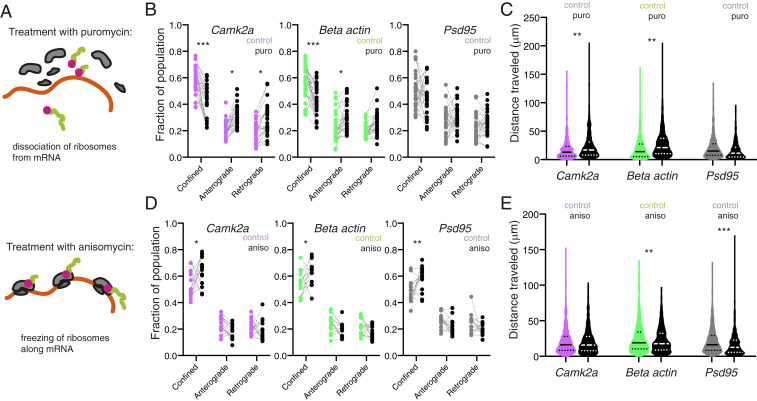
Manipulating ribosome association of mRNAs results in transcript-specific alterations in mRNA dynamics. (A) Schematic representation of the effects of puromycin (Upper) or anisomycin (Lower) on ribosomal association with mRNA. Puromycin results in ribosomal subunit disassembly, whereas anisomycin results in stalling of elongating ribosomes. (B) Quantification of mRNA dynamic state: confined, anterograde vs. retrograde for Atto647N Camk2a, Atto647N β-actin, and Atto647N Psd95 for control vs. puro treated samples. n = 29 cells per condition. *P < 0.05; ***P < 0.001. Paired t test. (C) Quantification of cumulative distance traveled for Atto647N Camk2a, Atto647N β-actin, and Atto647N Psd95 for control vs. puro-treated samples. n = 29 cells per condition. **P < 0.01 Sidak’s multiple comparisons test. (D) Quantification of mRNA dynamic state: confined, anterograde vs. retrograde for Atto647N Camk2a, Atto647N β-actin, and Atto647N Psd95 for control vs. anisomycin-treated samples. n = 15 cells per condition. *P < 0.05; **P < 0.01 paired t test. (E) Quantification of cumulative distance traveled for Atto647N Camk2a, Atto647N β-actin, and Atto647N Psd95 for control vs. anisomycin-treated samples. n = 15 cells per condition. **P < 0.01; ***P < 0.001 Sidak’s multiple comparisons test.